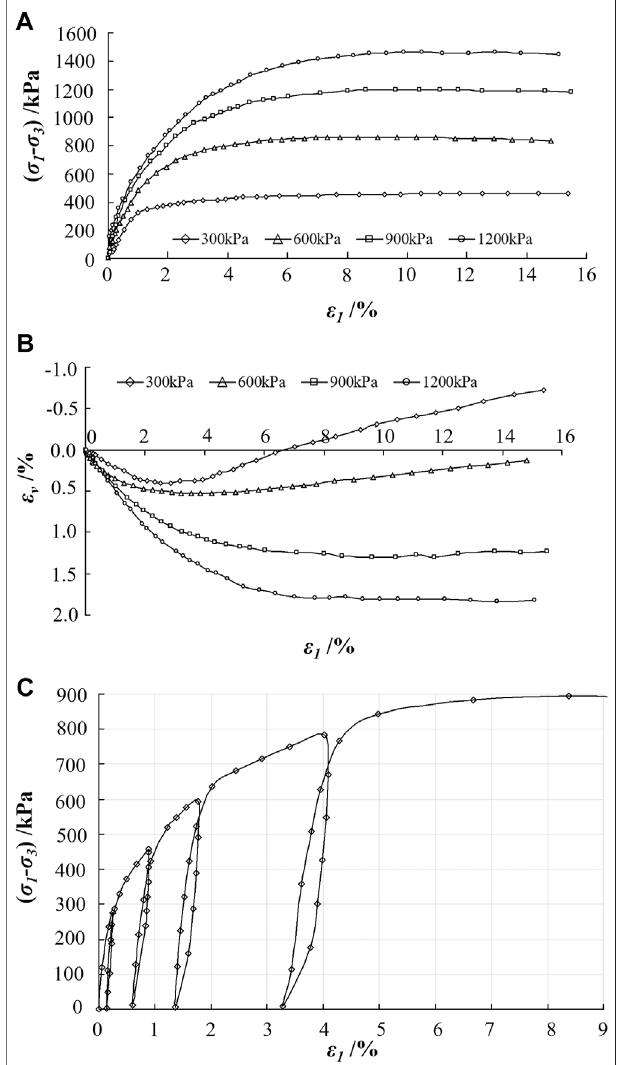
FIGURE 2 | Deformation curves: (A) the curves of stress versus strain; (B) the curves of volumetric strain versus axial strain; (C) the curves of stress versus strain of axial loading and unloading